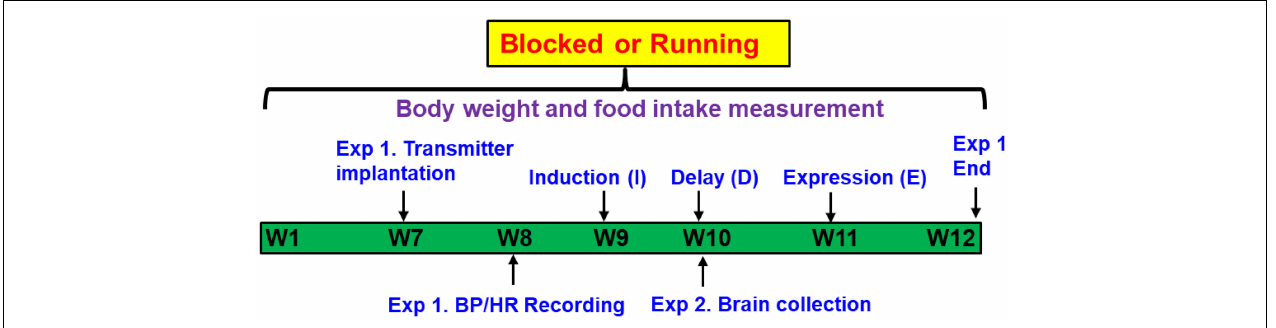
FIGURE 1 | Representative timeline of the study design. Adult male rats were given access to either “blocked” or functional running wheels for 10–12 weeks. Experiment 1 (Exp. 1): the Induction-Delay-Expression (I-D-E) paradigm was applied for the rats during the last 4 weeks. The rats were pretreated during Induction with a systemic subpressor dose of angiotensin (ANG) II (sc, 10 ng/kg/min) for 1 week. After a 1-week Delay, rats were treated during Expression with a pressor dose of ANG II (120 ng/kg/min) for 2 weeks. The hemodynamic and autonomic function were measured. Experiment 2 (Exp. 2): at the end of Delay, animals were euthanized to collect brain tissues for assessing mRNA expression of renin-angiotensin system components, NADPH oxidase and proinflammatory